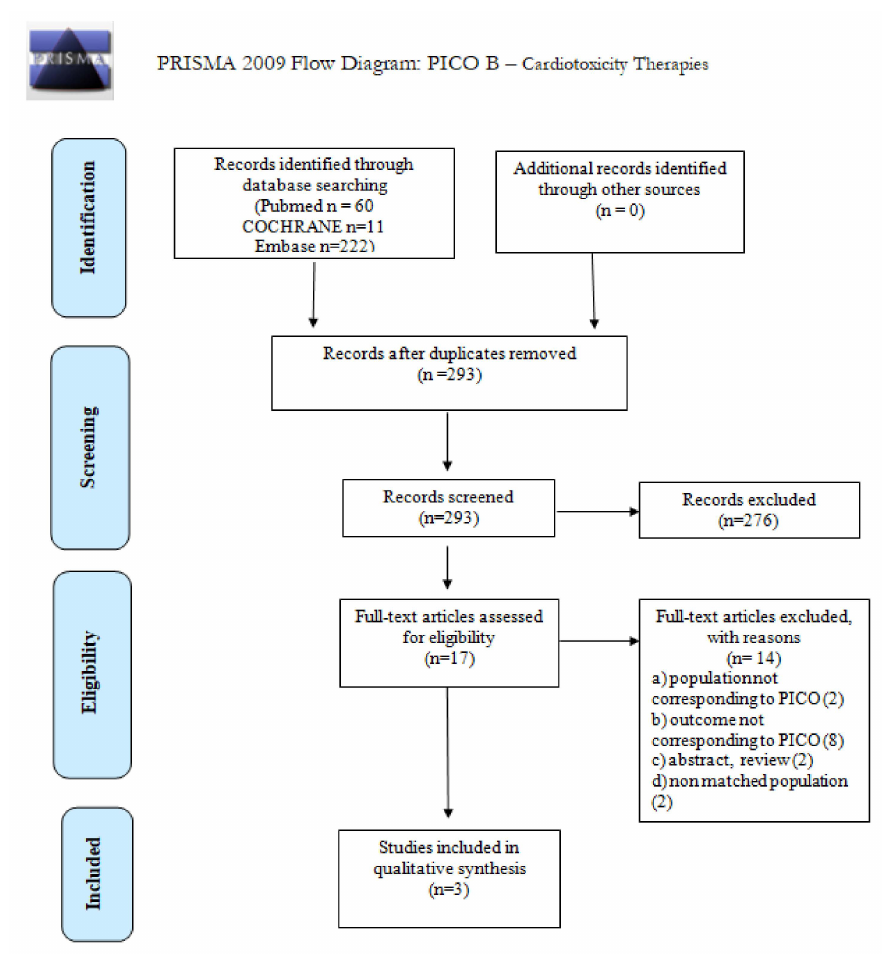
Figure 2. PRISMA 2009 Flow diagram for PICO B: cardiotoxic